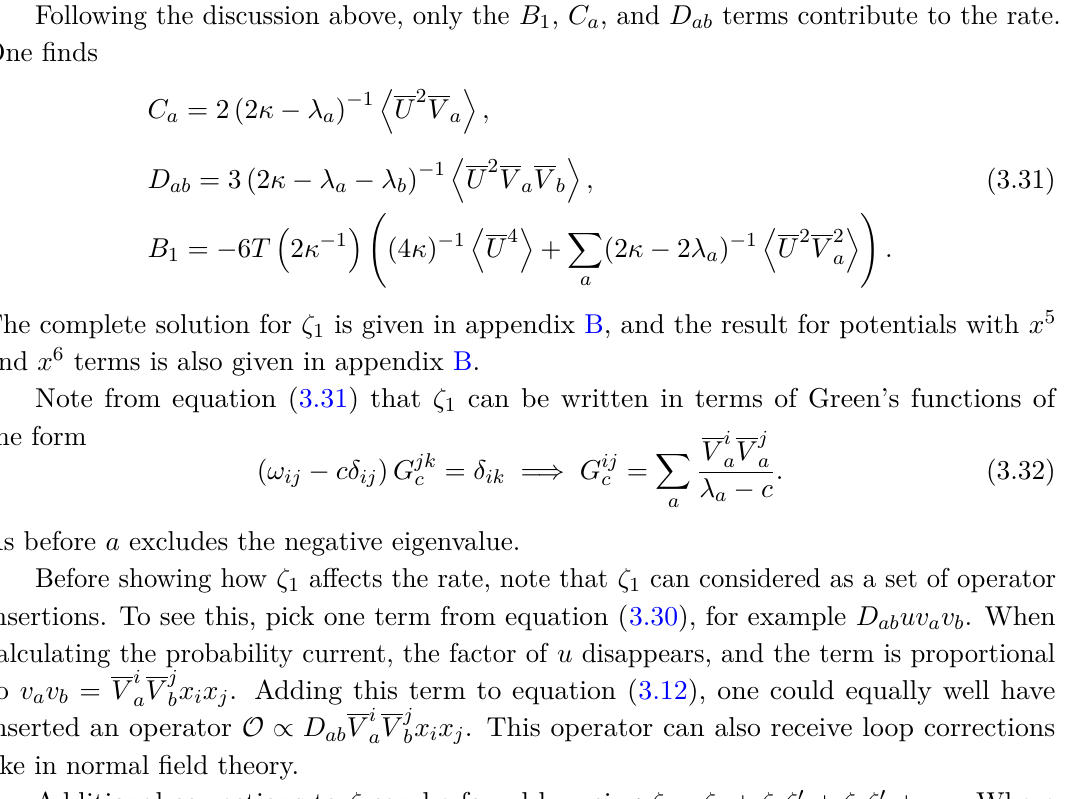
Figure 3 . Tadpole contribution to the dynamical